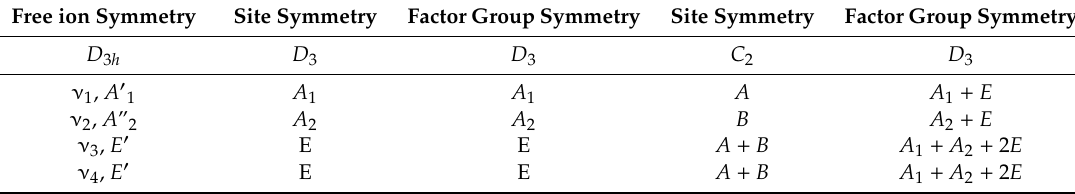
Table 3. Correlation diagram of internal vibrations of the BO 33 − in the YAB. Free ion Symmetry Site